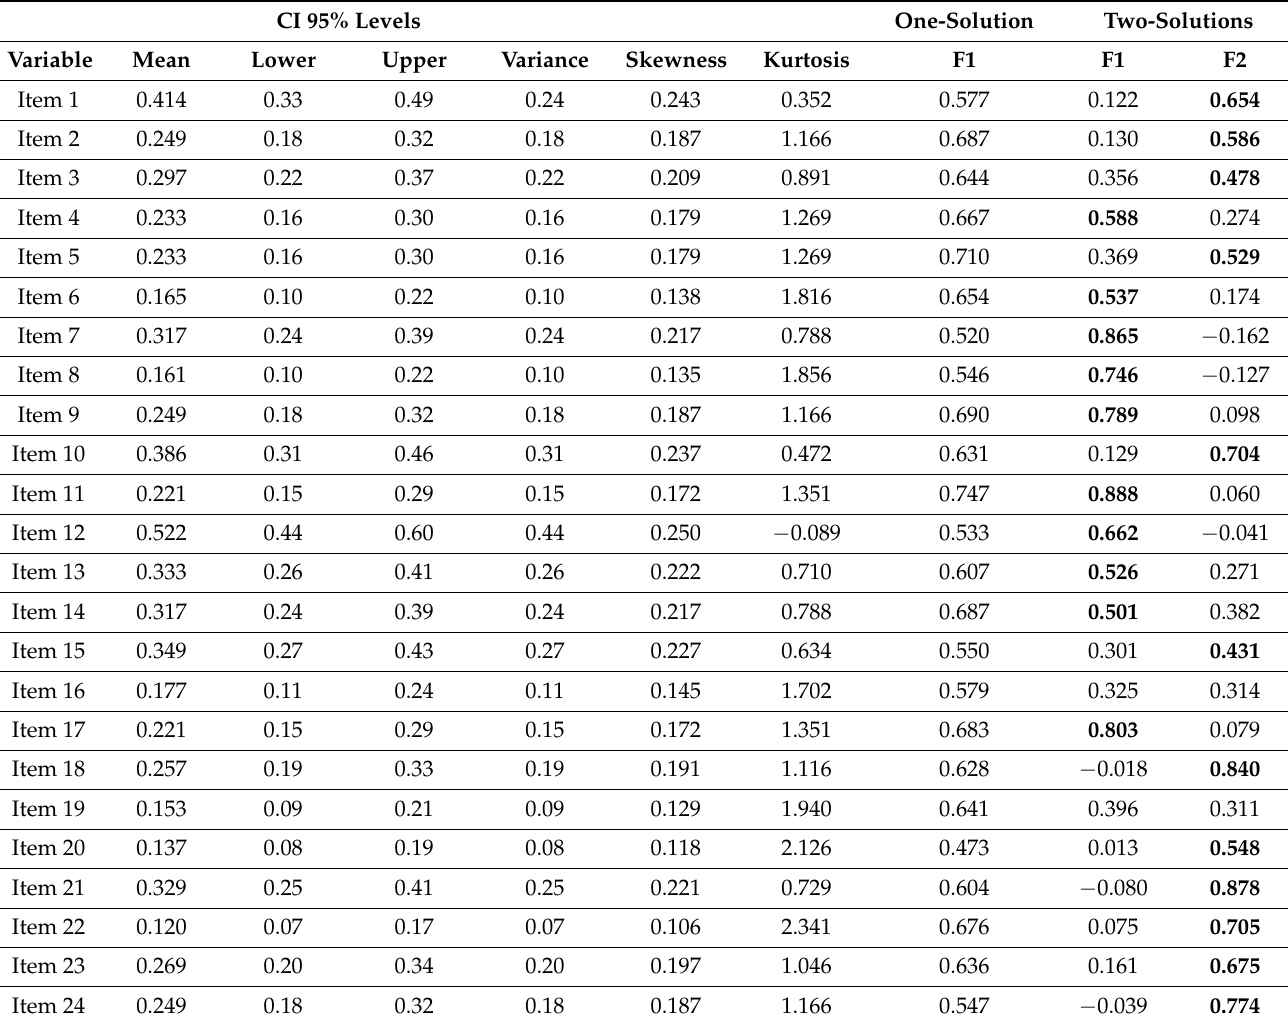
Table 1. Univariate descriptives and factor loadings in the older sample for the SCD-Q ( n = 249). Bold indicates the factor loading items included for a 2-factor solution (values >